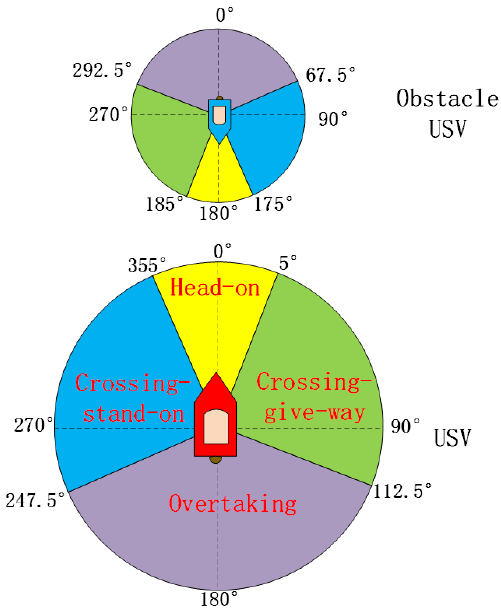
Figure 1. Encounter angle division of USVs under the COLREGs.